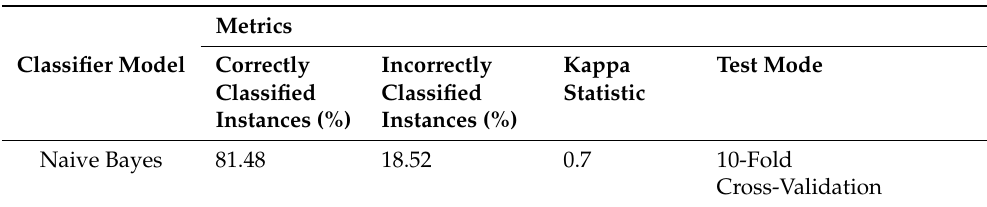
Table 3. Naive Bayes classifier performance for scale class prediction models of the level of the energy-environmental e ffi ciency of